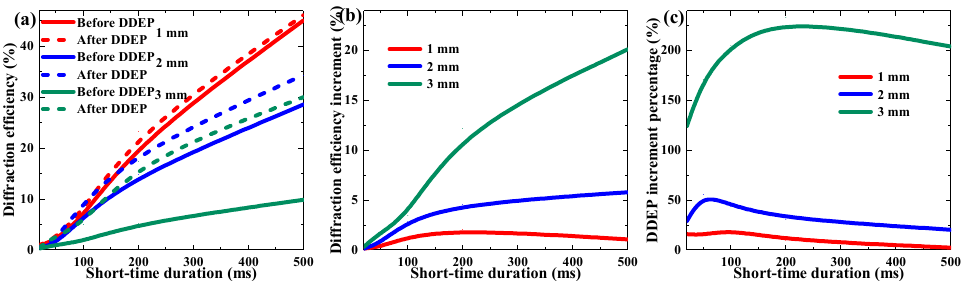
Figure 10. Effect of exposure time with different short-time durations on multi-shots DDEP of materials with different thickness: ( a ) maximum diffraction efficiency, ( b ) diffraction efficiency increment, ( c ) DDEP increment percentage.